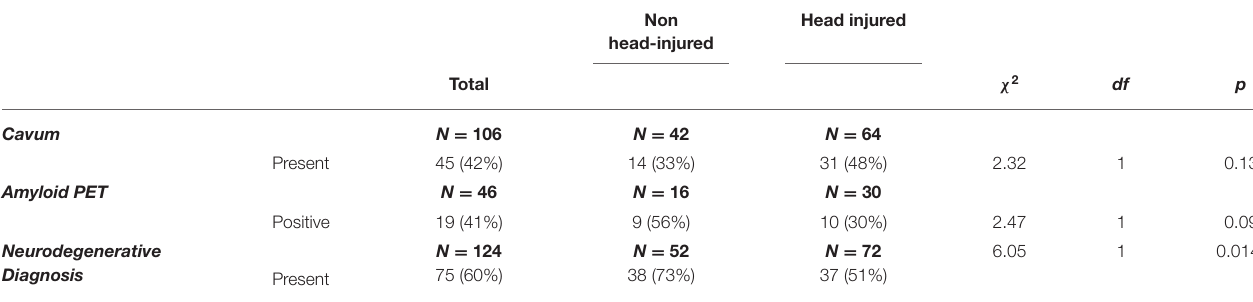
TABLE 2 | Imaging and clinical findings.